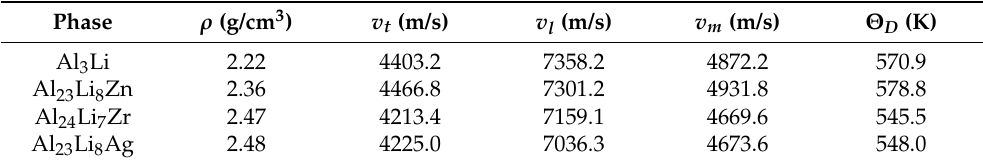
Table 4. The density ρ , transverse sound velocity v t , longitudinal sound velocity v l , mean sound velocity v m and Debye temperature Θ D of pure and doped Al 3 Li